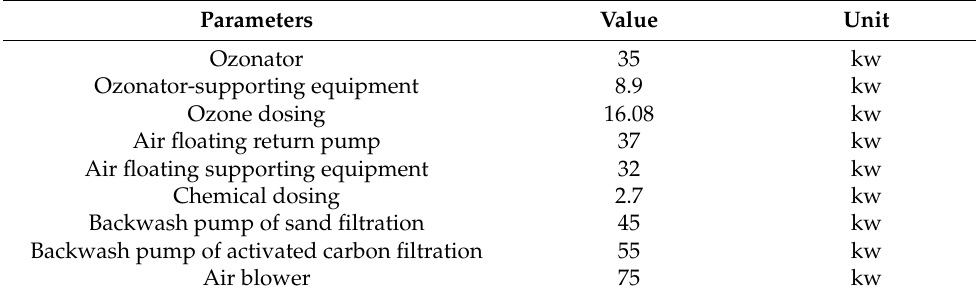
Table 1. Power consumption of the equipment.